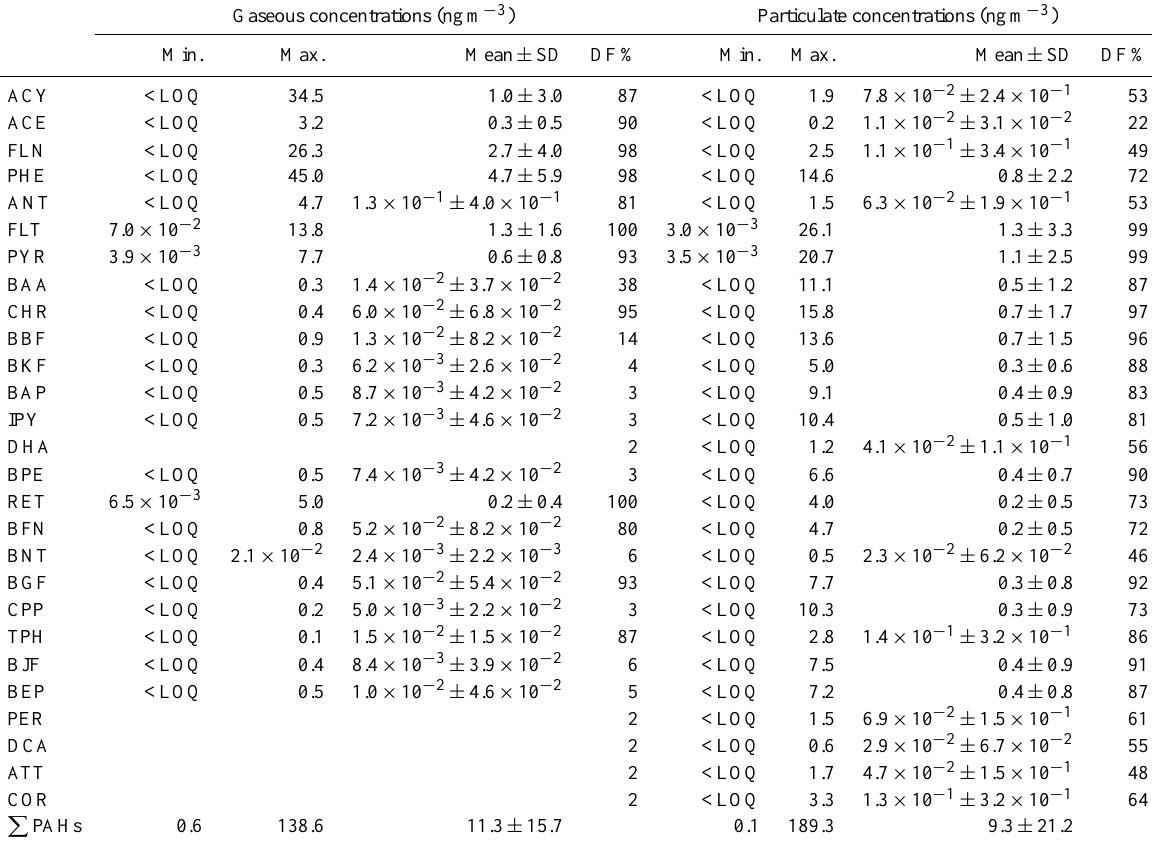
Table 1. PAH concentrations and detection frequencies (DF) in air (n = 162 )